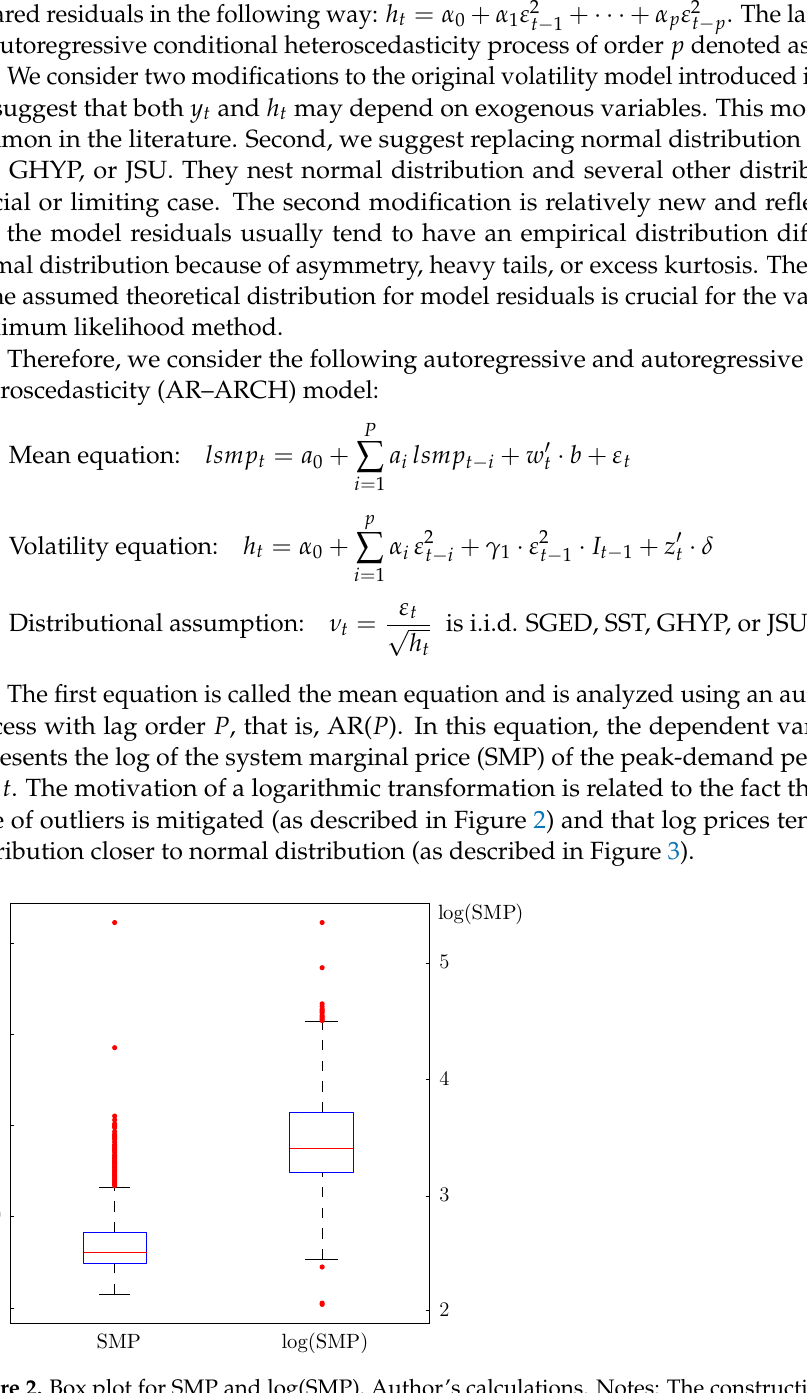
Figure 2. Box plot for SMP and log(SMP). Author’s calculations. Notes: The construction of the box plot for detecting outliers does not require any distributional assumption. The box plot with whiskers is constructed using the interquartile range. Points beyond the whiskers correspond to outliers. We do not use the rule of three sigmas for detecting outliers because the empirical distribution of data did not conform to the fitted normal